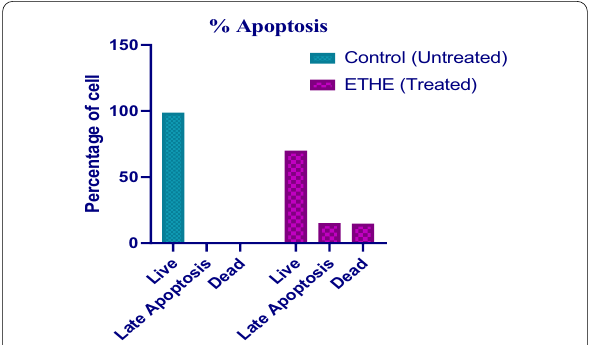
Fig. 6 Flow cytometric analysis of the proportion of apoptotic cells